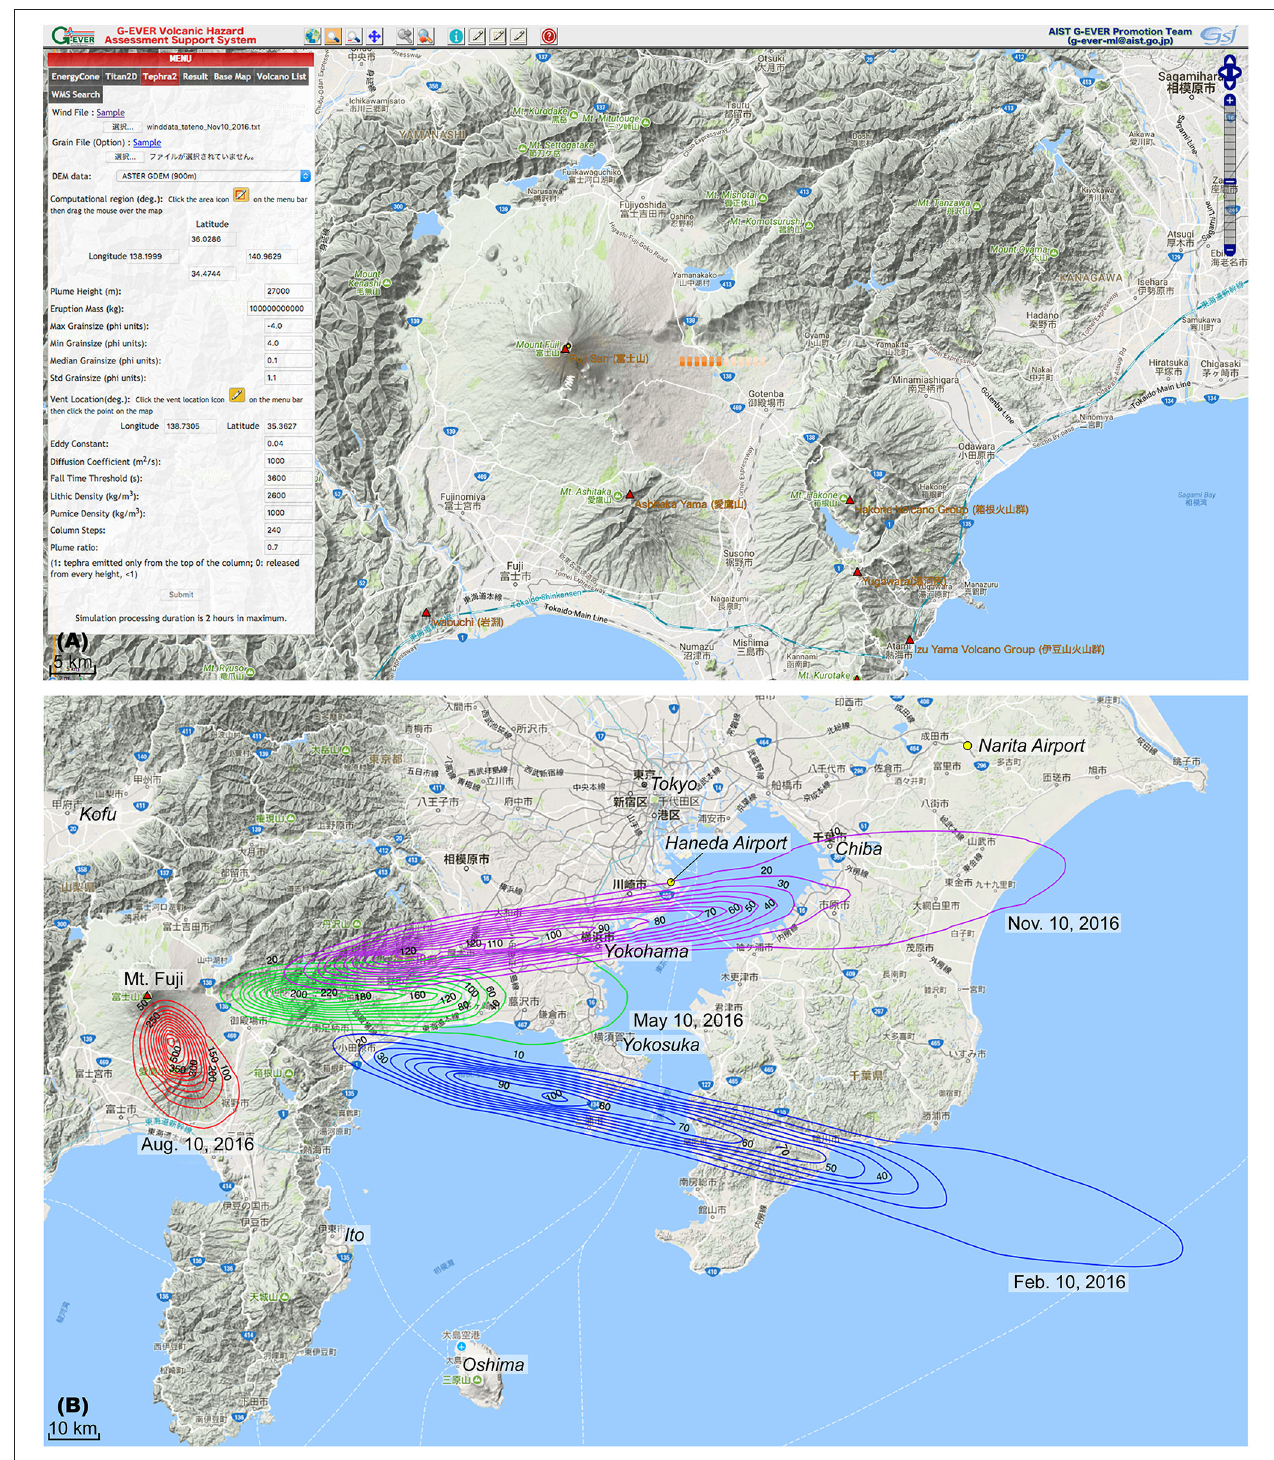
FIGURE 9 | Tephra2 simulation at Fuji Volcano, Japan on the VHASS system. (A) Tephra2 simulation menu. (B) Isomass contour maps created using GIS software and four wind data at 9:00 a.m. on Feb. 10 (blue), May 10 (green), Aug. 10 (red), and Nov. 10 (purple), 2016 are shown on a Google map (kg/m 2 ). Locations of Haneda and Narita Airports are